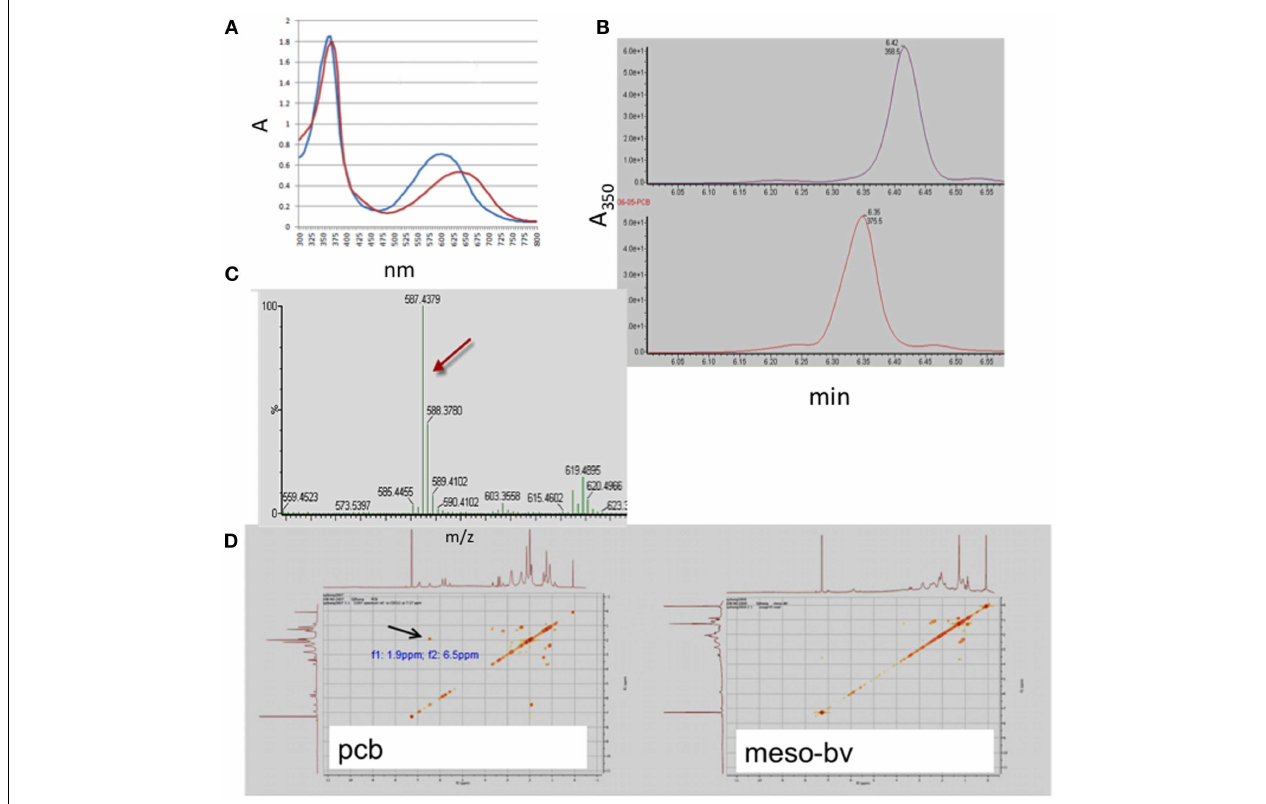
COZY spectra (D) of mesobiliverdin IX α (mesoBV, right panel) and phycocyanobilin (pcb, left panel).The red arrow in (C) indicates a molecular mass of 587.4 for mesobiliverdin IX α .The black arrow in (D) indicates a = CH-CH3 functional group (at f 1 : 9ppm; f 2 :6.5ppm) in phycocyanobilin that is absent in mesobiliverdin IX α